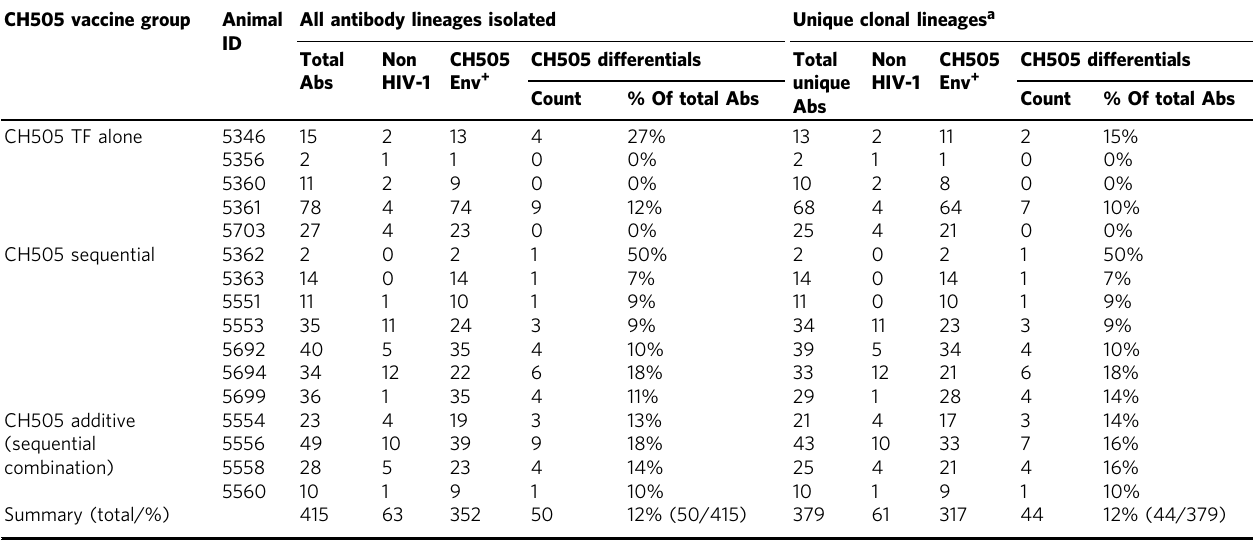
Table 1 Frequency of antibodies isolated from CH505 envelope-vaccinated macaques CH505 vaccine group Animal